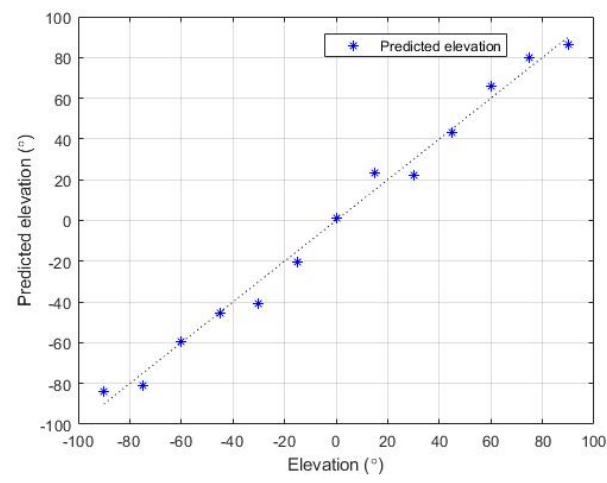
Figure 15. Predicted elevation values compared to actual values.